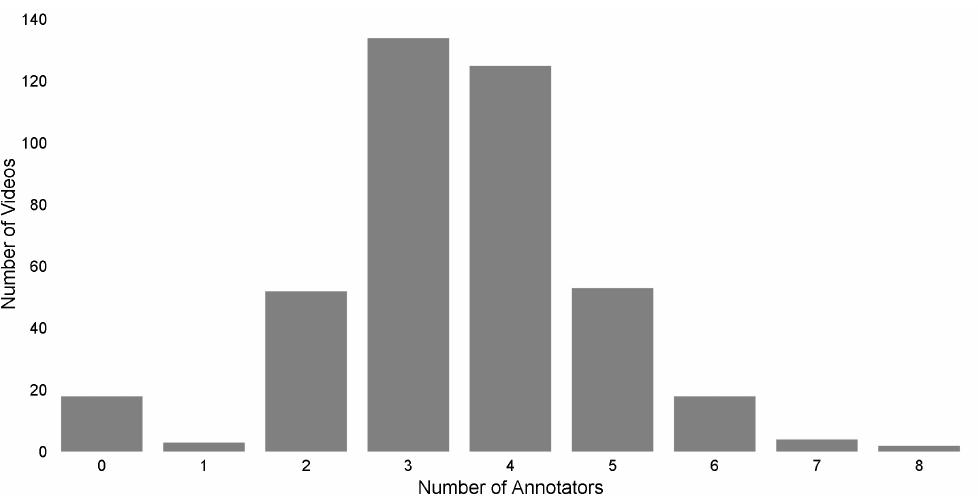
Figure 4. Distribution of the number of users annotated each video. Only 73 videos have been annotated by only 2 or less